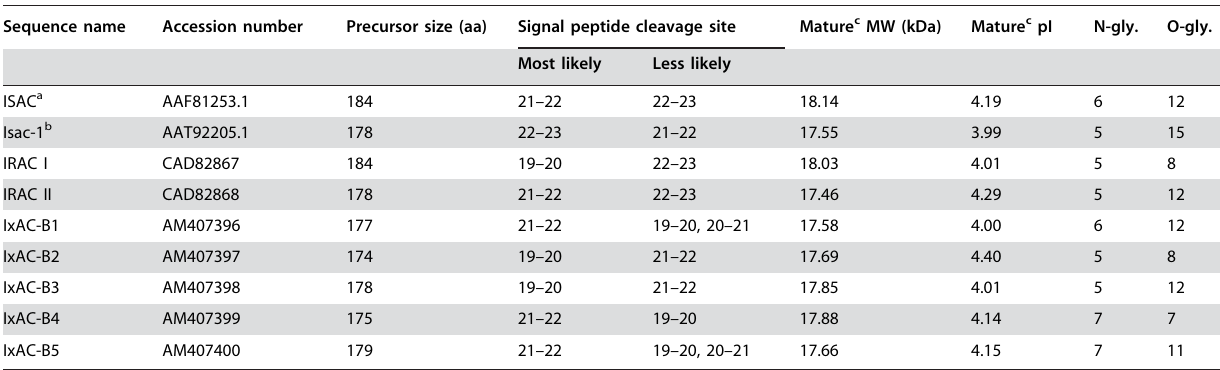
Table 3. Calculated properties of anticomplement proteins. .. ... .... ... ... .... ... ... .... ... ... .... ... ... .... ... ... .... ... ... .... ... ... .... ... ... .... ... ... .... ... ... .... ... ... .... ... ... .... ... ... .... ... ... .